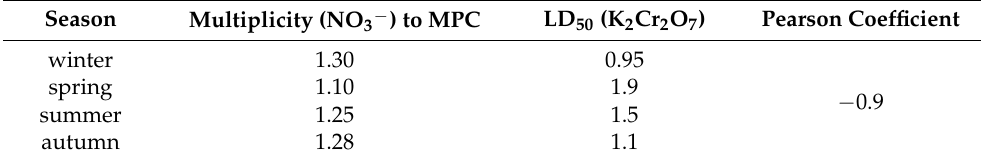
Table 5. Influence of the content of nitrate anions on the sensitivity of D. magna to a model toxicant.